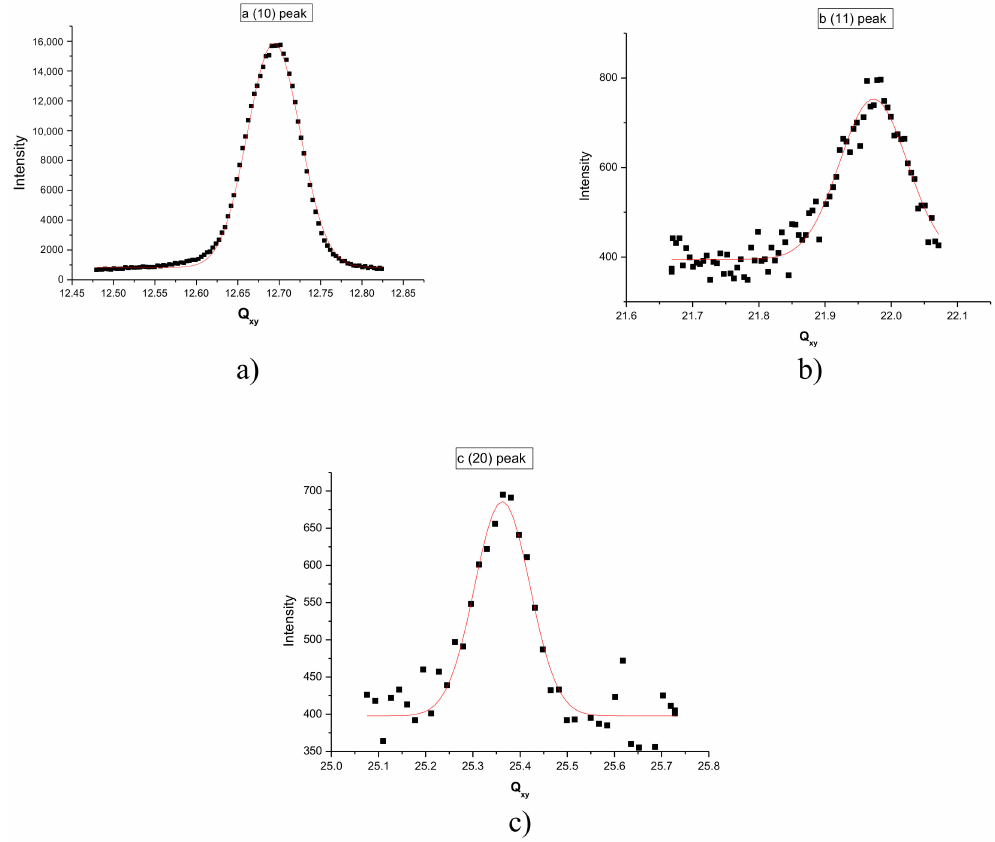
Figure 3. Q z integrated di ff raction spectrum at 18 ◦ C and 15 mN / m of the Langmuir film of F18OH.